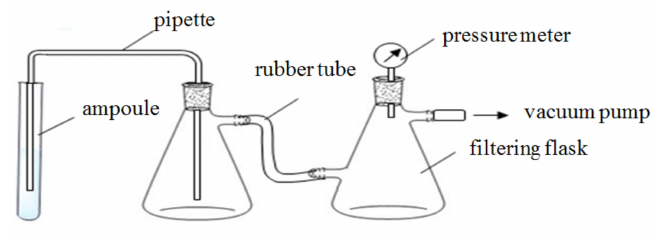
Figure 1. Schematic diagram of the breakthrough vacuum setup.